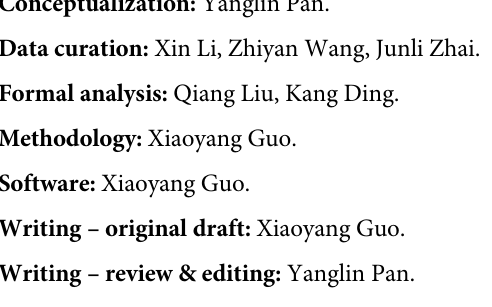
S9 Fig. Secondary outcome: A, BBPS score; B, OBPS score. (TIFF) S10 Fig. Secondary outcome: A, ADR; B, PDR. (TIFF) S11 Fig. Secondary outcome: A, insertion time; B, withdrawal time. (TIFF) S12 Fig. Secondary outcome: Adverse events. (TIFF) S13 Fig. Secondary outcome: A, > 80% purgative intake; B, diet compliance. (TIFF) S14 Fig. Funnel blot indicating no significant publication bias (Revman). (TIFF) S15 Fig. Funnel blot indicating no significant publication bias (Stata). (TIFF) S16 Fig. Forest plot comparing BP quality between RE and SE group (Stata). (TIFF) S1 Table. Details of each included study. S2 Table. Details of quality assessment using modified Jadad